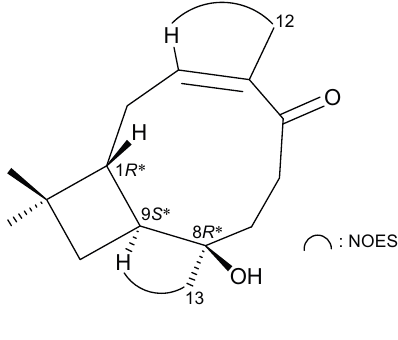
Figure 2. Selective NOESY correlations of 1